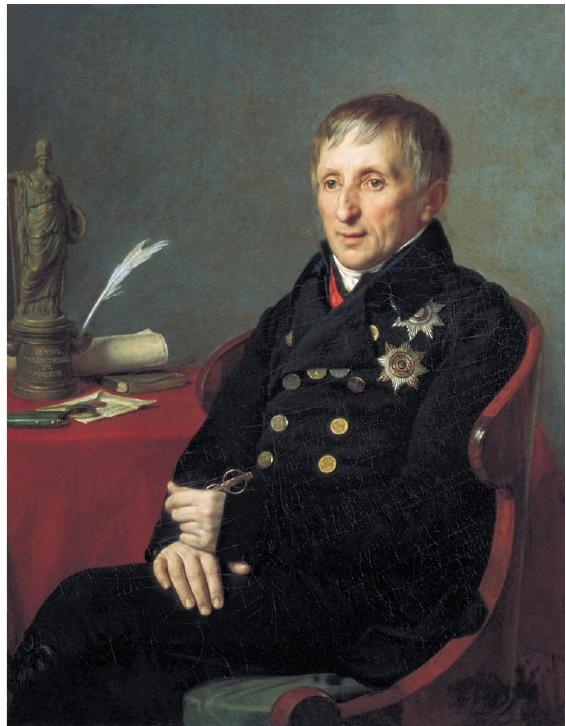
Figure 18. Alexander Varnek. A Portrait of Aleksei Olenin , 1824. Research Museum of the Russian Academy of Arts, Saint Petersburg.